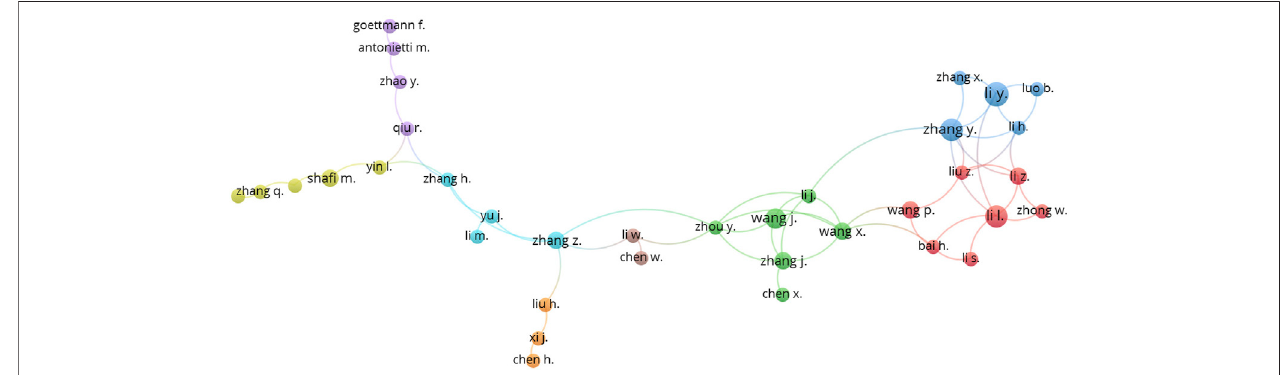
FIGURE 4 | Global cooperation networks of co-authors in sustainable crafts. Source: Authors ’ own.